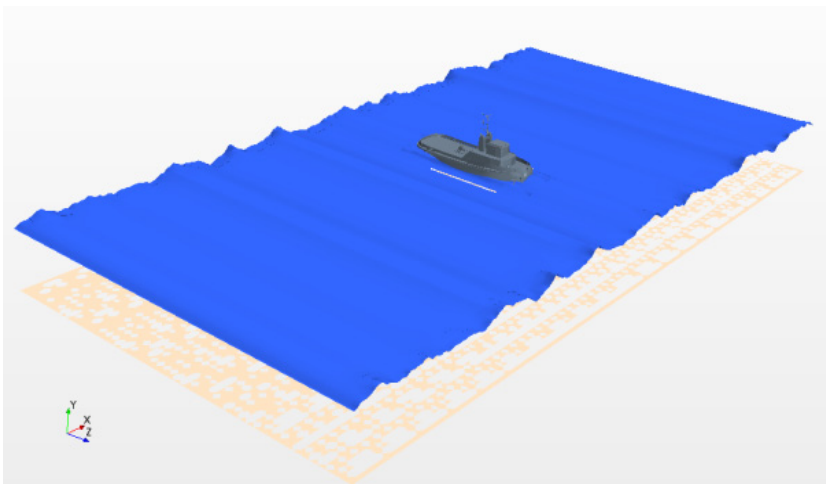
Figure 5. Scalar figure of the tug ship with a gyrostabilizer in the numerical simulation. In numerical simulation, the frictional resistance of the flywheel spinning and the interaction effect of the yaw and roll were ignored. The mesh independence and step-length independence were verified for numeri- cal simulation to ensure the credibility of the simulation results. The time step ∆ t was calculated by the following